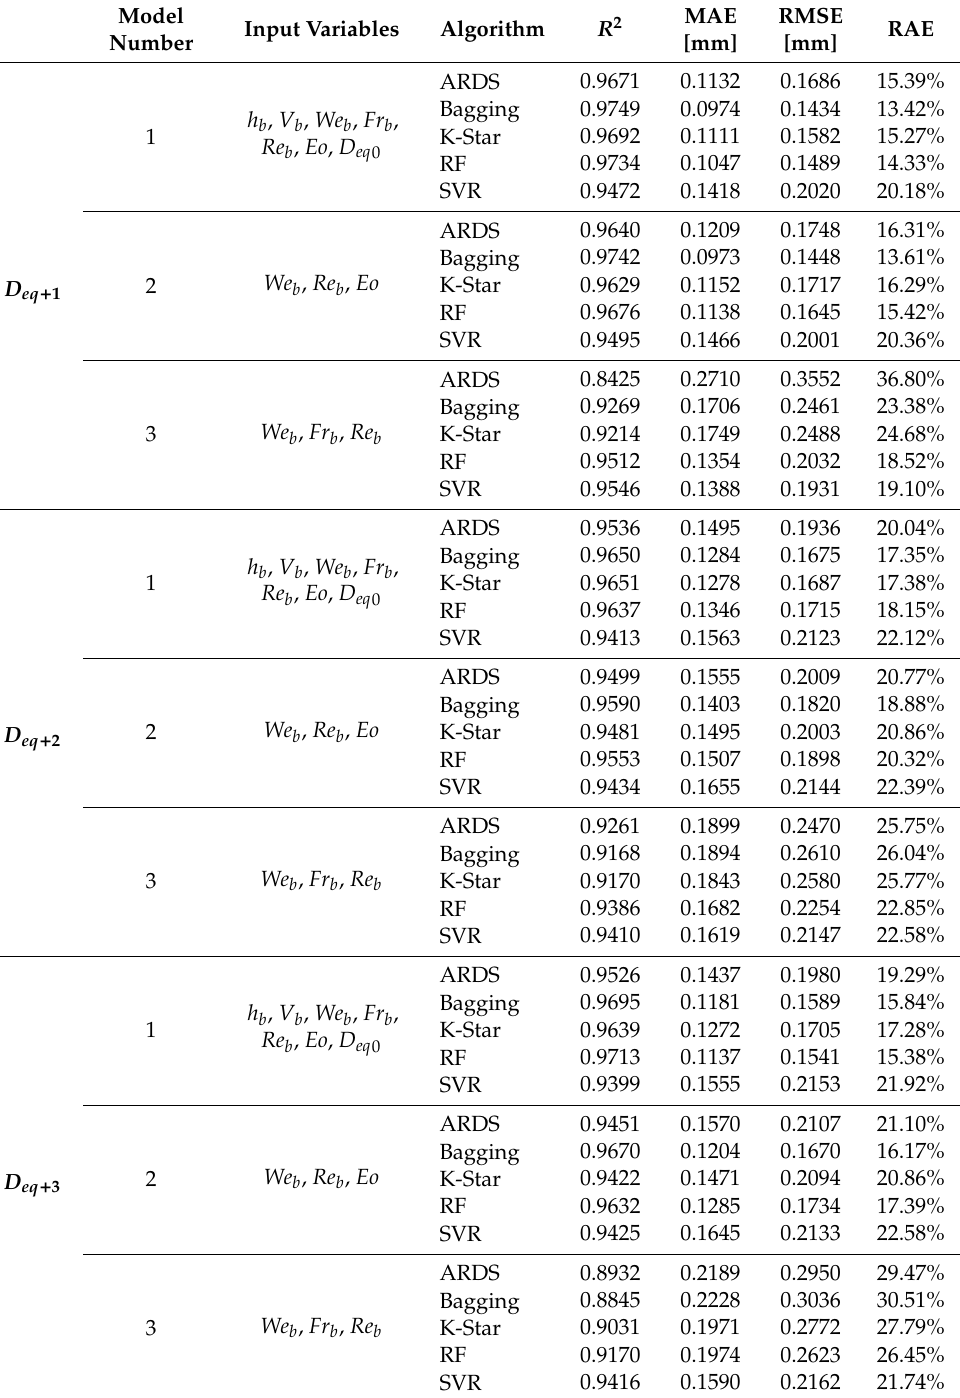
Table 1. Synthesis of the results of equivalent diameter ( D eq ) prediction